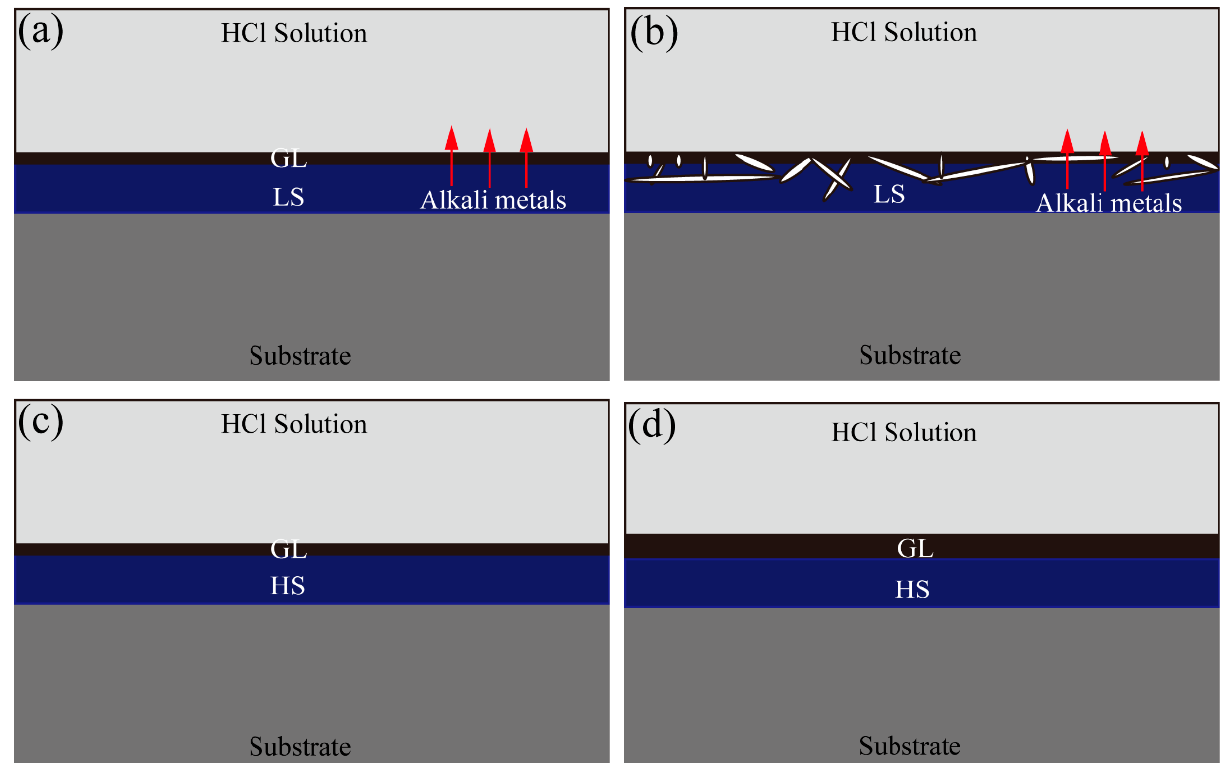
Figure 12. Schematic diagram of the corrosion processes of the LS ( a , b ) and the HS ( c , d ).